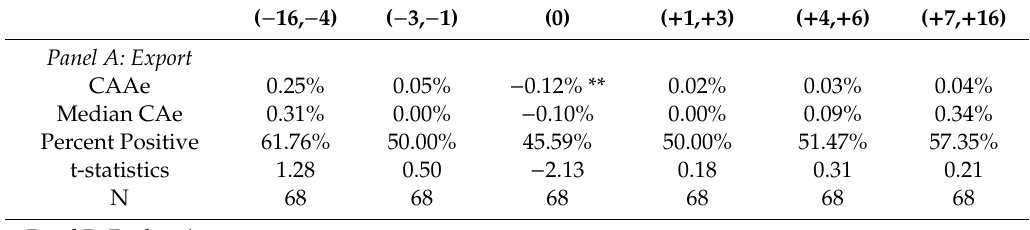
Table 2. The e ff ect of gas discoveries on the exchange rate by announcement